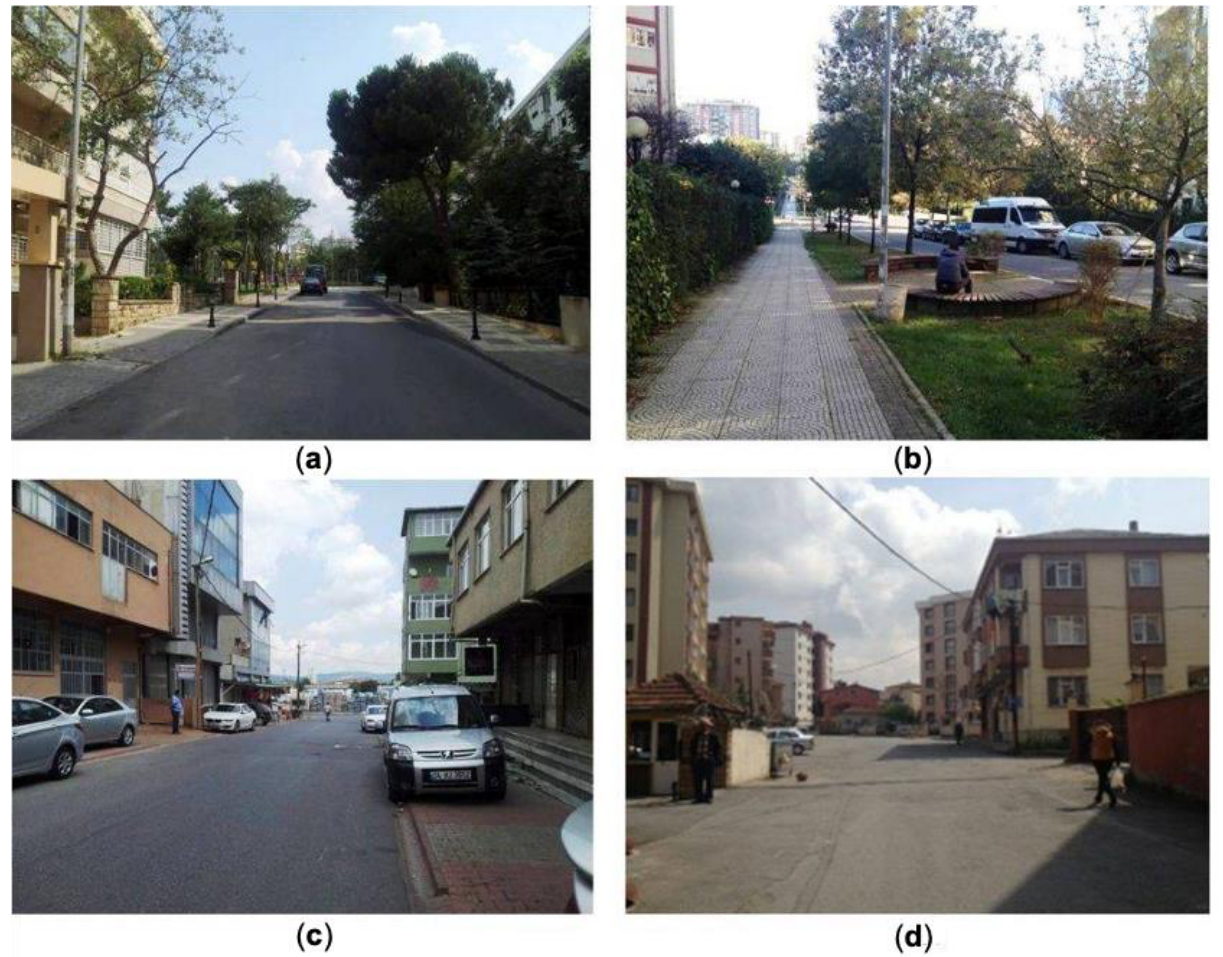
Figure 2. Typical streets within home-neighborhoods in ( a ) Kadıköy, ( b ) Ata¸sehir, ( c ) Ümraniye, and ( d ) Figure 2 . Typical streets within home-neighborhoods in ( a ) Kadıköy, ( b ) Ataşehir, ( c ) Ü mraniye, and ( d ) Kartal.